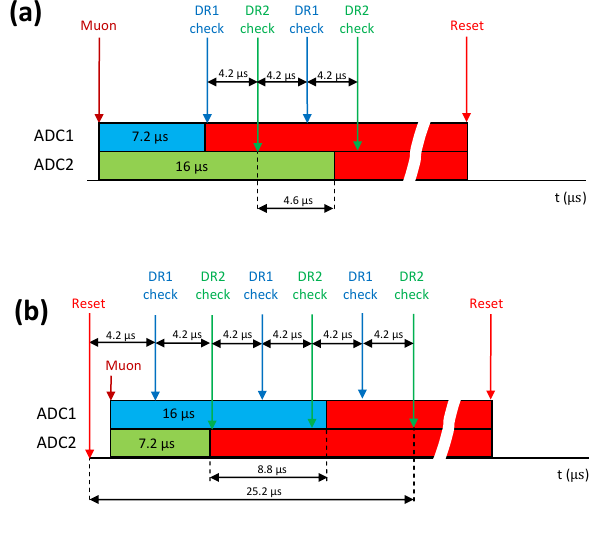
Figure 12. Coincidence evaluation. Maximum and minimum conversion times and waiting time to ensure ADC